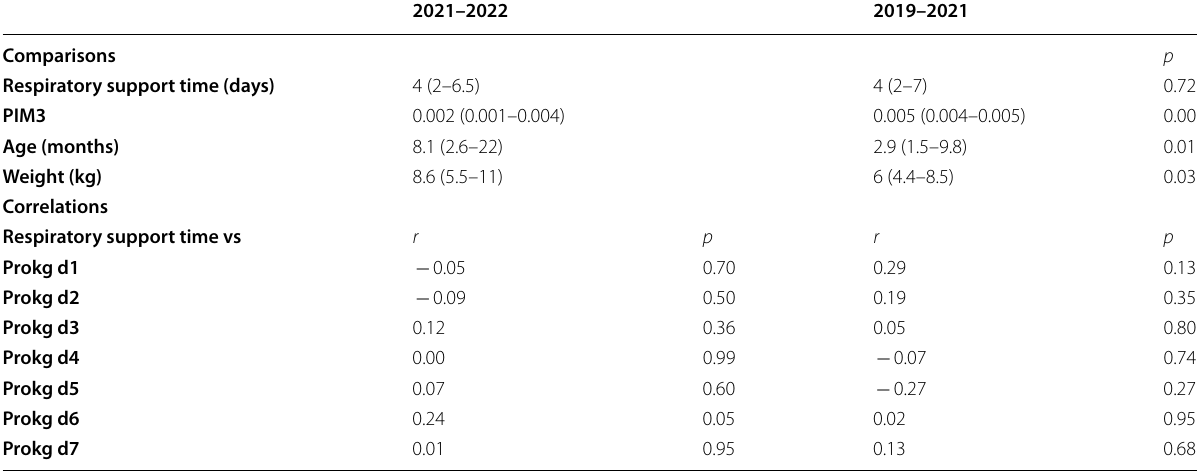
PIM3 pediatric index of mortality 3. The table also reports the correlation of respiratory support time with daily fluid balances (prokg) from day 1 to day 7 in both